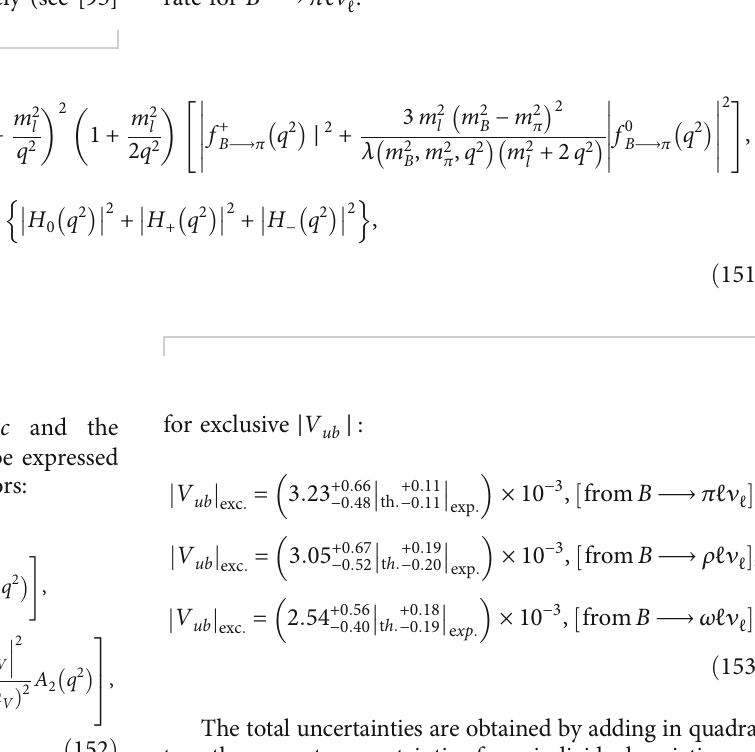
Table 2: The resonance masses with di ff erent quantum numbers entering the z -series expansions of the B ⟶ V form factors (149) where Þ / ð n · p ÞÞ A = ðð m + m A 12 B V (cid:3) (cid:4) q 2 f i B ⟶ V